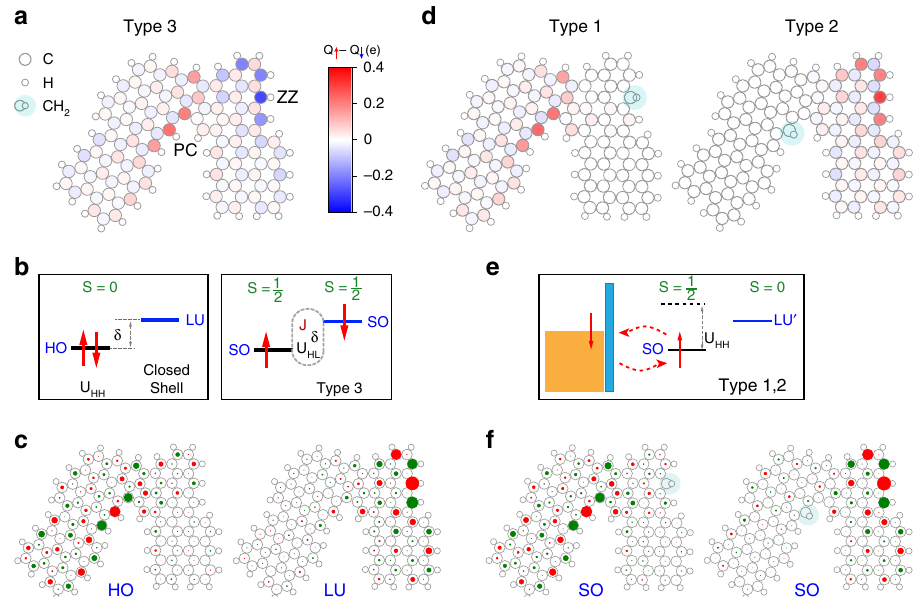
Fig. 3 Calculated electronic states and spin polarization. a Spin polarization obtained from DFT simulations in a Mulliken population analysis. The standard junction (all peripheral carbons bonded to H) shows spontaneous spin localization in both PC and ZZ regions, revealing the apparition of radical states. b Schema of the spontaneous spin polarization when one of the two electrons in the HO level gets promoted to the LU level to form two separated, exchange coupled spin-1/2 systems (Type 3 junction). This process is energetically favored when the reduction in Coulomb energy U HH − U HL plus exchange energy J exceeds the level separation δ , i.e., δ + U HL − J < U HH . c Single-particle TB wave functions (HO/LU) for Type 3 junction. d Same as in a but now adding a H atom to an external carbon in either the ZZ (Type 1) or PC (Type 2). The passivation with H removes the corresponding radical state and, hence, its spin-polarization. e Sketch of the spin-1/2 Kondo state generated with a single radical (Type 1 and 2 junctions). f Single-particle TB wave functions (SO) for Type 1 and Type 2 junctions. Red-green colors represent the positive-negative